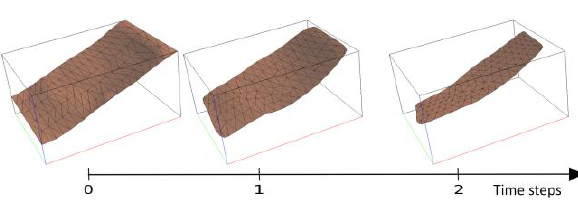
Figure 1. 4D model composed of three 3D models, each representing a different time step Professional geodatabases provide a comfortable